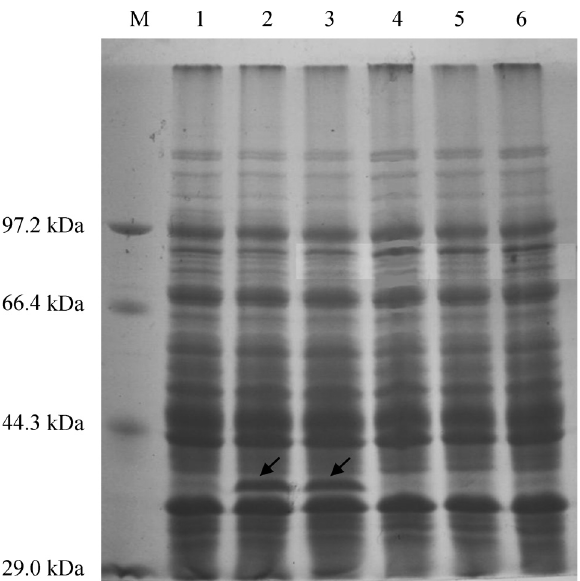
Figure 3 - Expression of a pET30a-WOX2 fusion protein. Lane 1, unin- duced pET30a-WOX2; lanes 2-3, pET30a-WOX2 induced by 0.5 mM IPTG for 3 and 5 h, respectively; lane 4, uninduced pET30a; lane 5, in- duced pET30a for 3 h; lane 6, negative control E. coli BL21 (DE3); M, Protein Molecular Weight Marker (Low) (TaKaRa). The target protein is indicated with